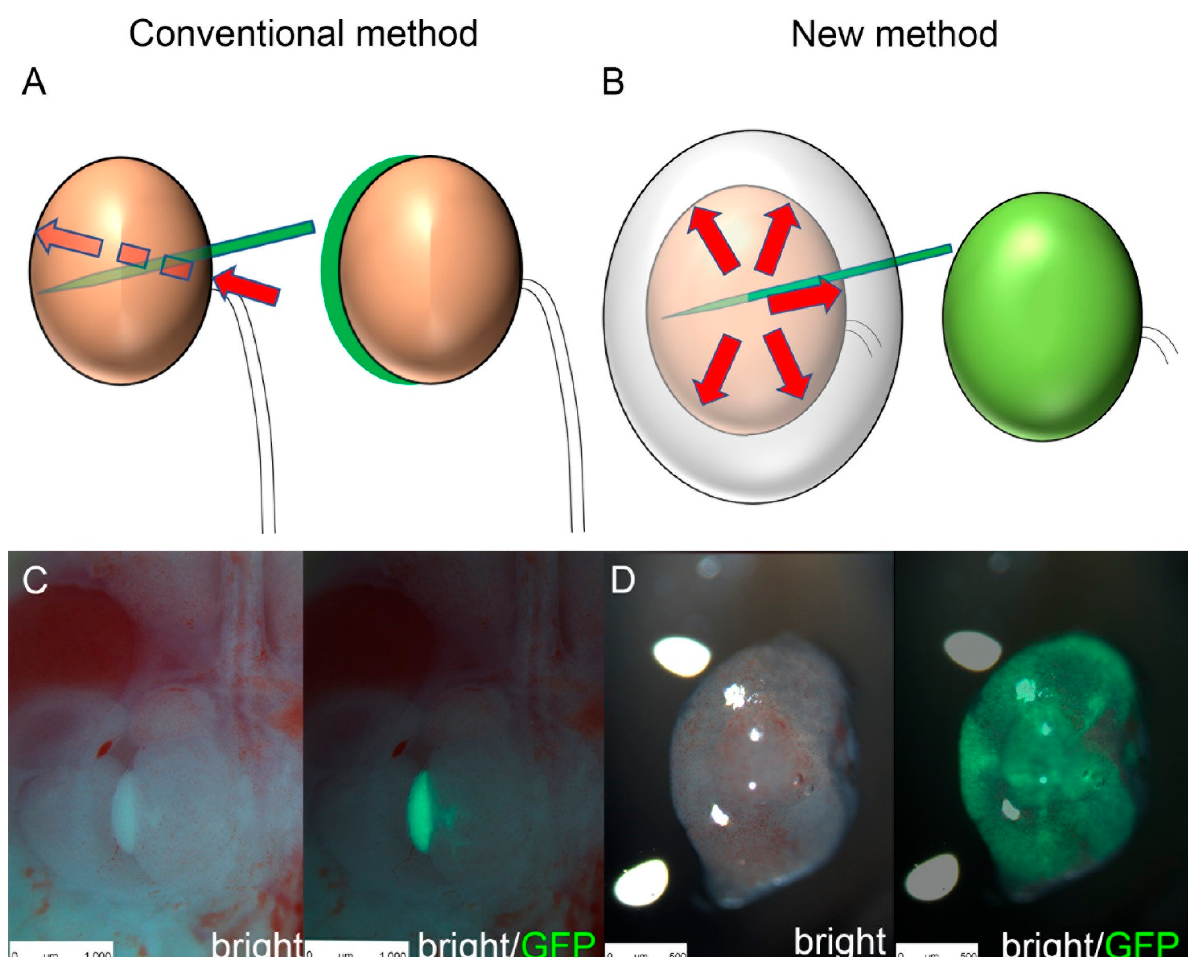
Figure 1. Schematic of cell transplantation methods. ( A ) Schematic of the conventional method. It is necessary to penetrate the renal parenchyma from the renal hilum. ( B ) Schematic of the new method. It can transplant cells into any renal capsule. ( C ) Representative fluorescence stereomicroscopy images of cell transplantation by the conventional method. Mouse Green fluorescent protein (GFP) renal progenitor cells were injected into an E14.5 Six2-GCE+/diphtheria toxin fragment A+ metanephros. ( D ) Representative fluorescence stereomicroscopy images of cells transplanted by the new method.